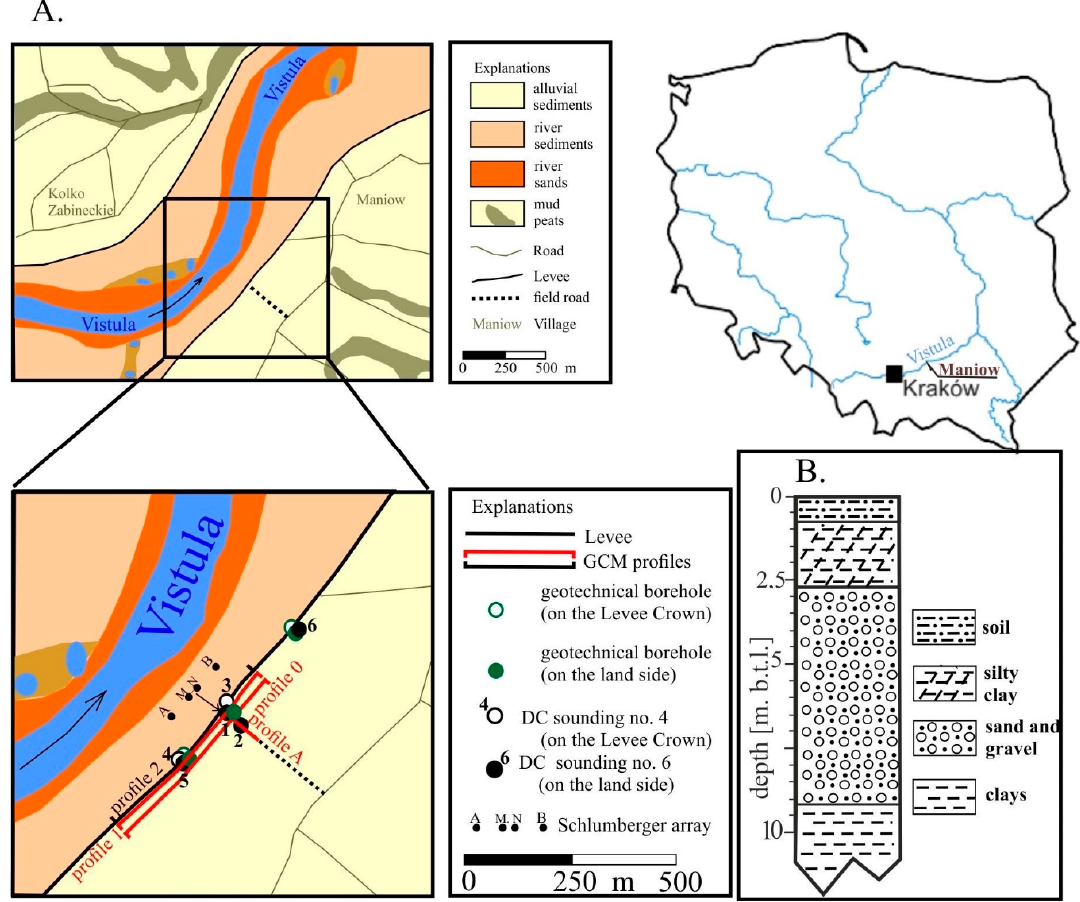
Figure 1. Location of the study area on the geological sketch; ( A )—sheet M34-67A Szczucin, 1:50,000 edited by Walczowski (1968) modified by authors with geophysical profiles; ( B )—simplified lithology on the borehole close to DC sounding no 1.